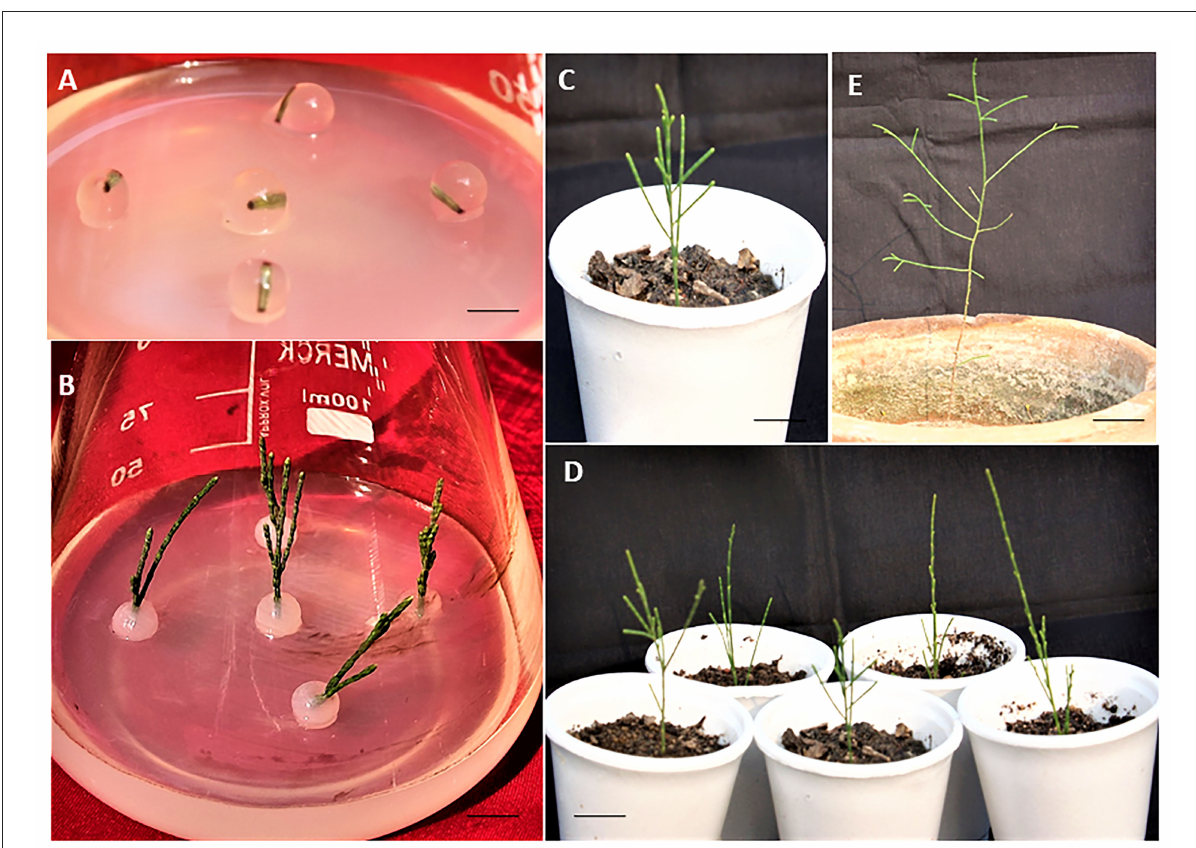
FIGURE2 Synthetic seed production and acclimatization of direct regenerated plants of C. equisetifolia . (A) Uniform synthetic seed on MS + BA (5.0 µ M) + NAA (0.5 µ M) (1 day old) (Bar = 1.03cm). (B) Sprouting of multiple shoots on the same medium (4 weeks old) (Bar = 0.91cm). (C,D) Successfully acclimatized plant (8 weeks old). (Bar = 1.8cm and 2.1). (E) Transfer in the field (6 months old) (Bar =